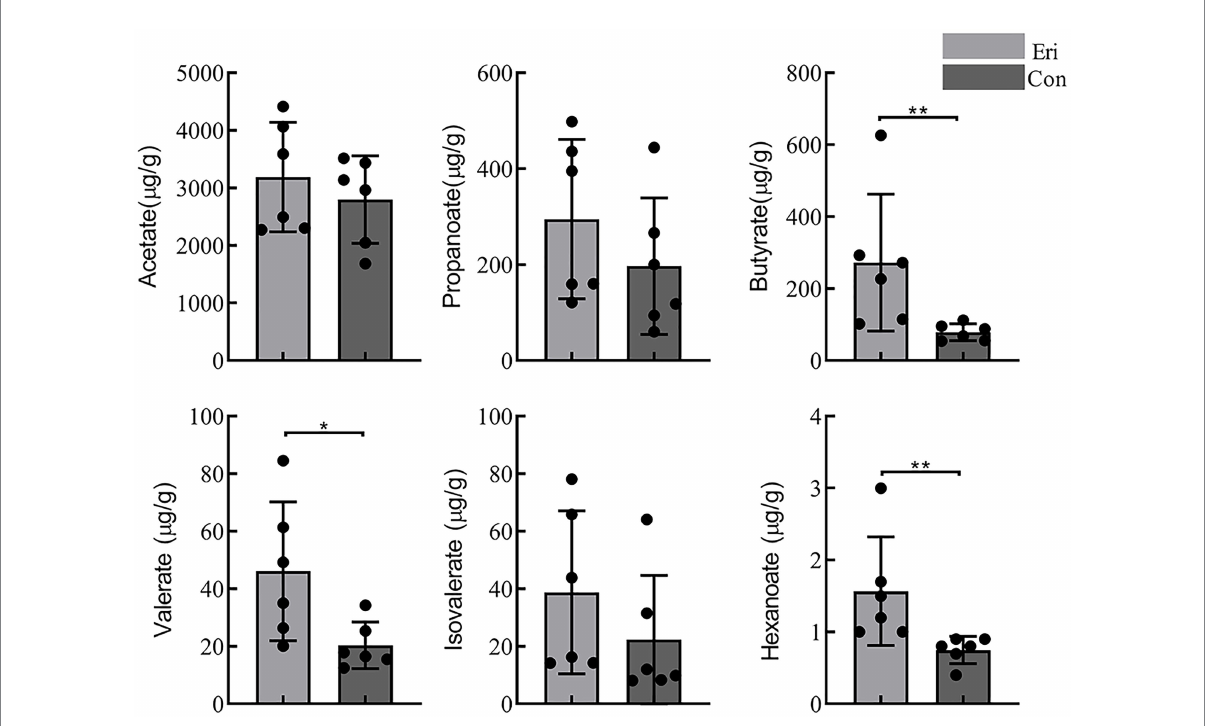
FIGURE 4 Short chain fatty acids content (SCFAs) in control and eriocitrin-treated mice colons. * p < 0.05, ** p <